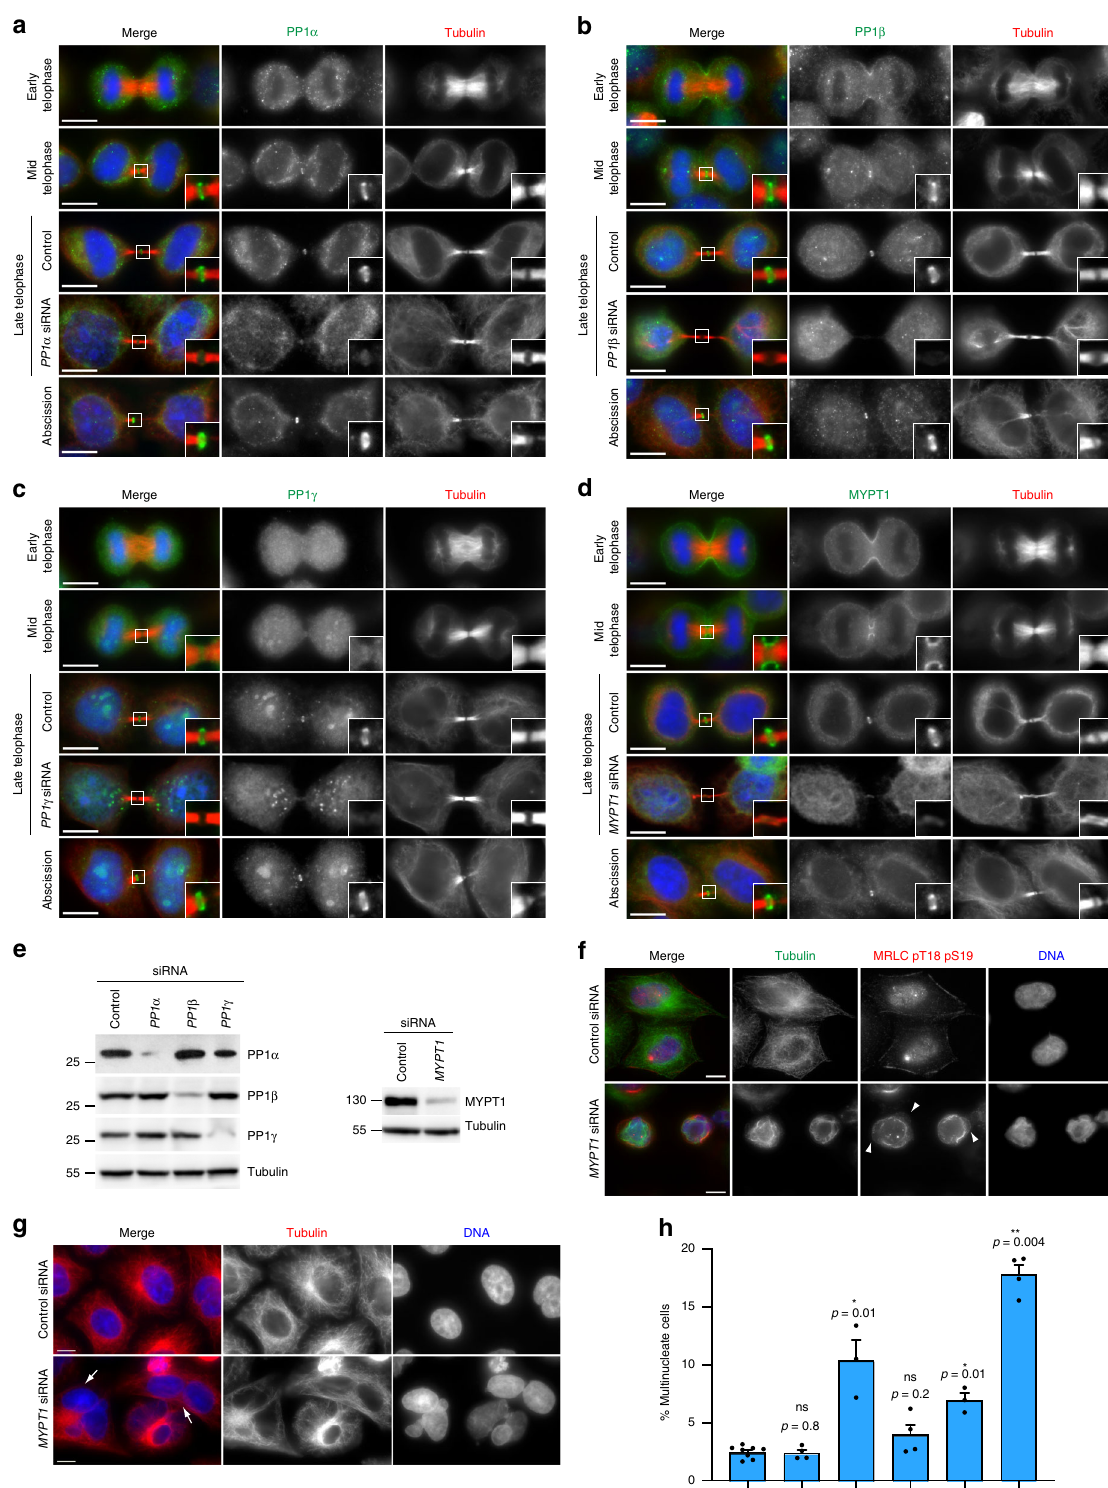
PP1 β dephosphorylates the centralspindlin component MKLP1 . Central spindle assembly depends on various micro- tubule associated proteins (MAPs) 2 , including two key protein complexes: centralspindlin, a hetero-tetramer composed of two MKLP1 and two RacGAP1 subunits, and the PRC1-KIF4A complex. These MAPs have been shown to interact and